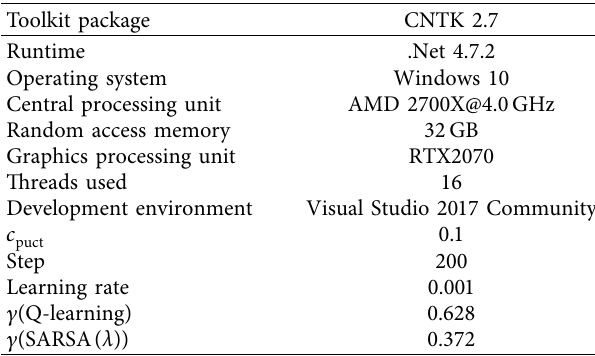
Figure 4: The deep neural network structure. Table 1: The experimental parameters.